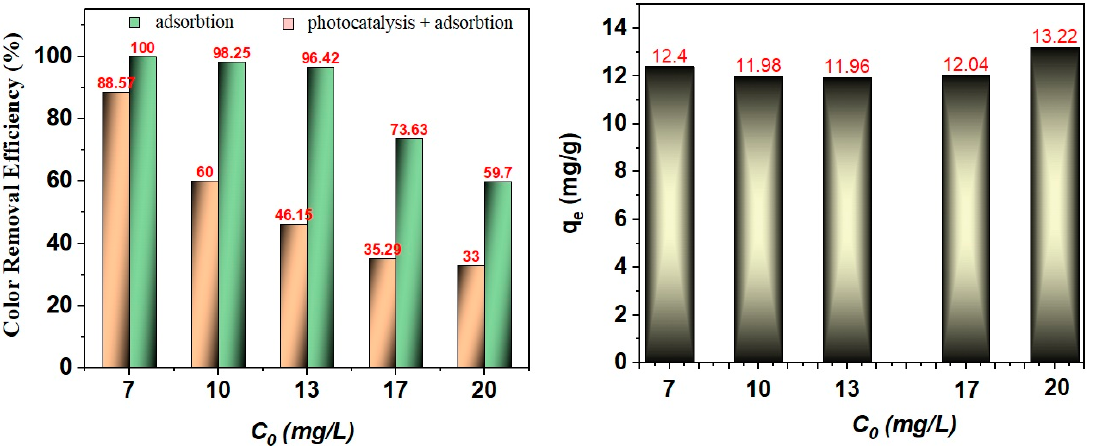
Figure 9. Color removal e ffi ciency after adsorption and photodegradation ( left ), and the maximum adsorption capacity of M1 (T) catalyst ( right ) for Methylene Blue (MB)